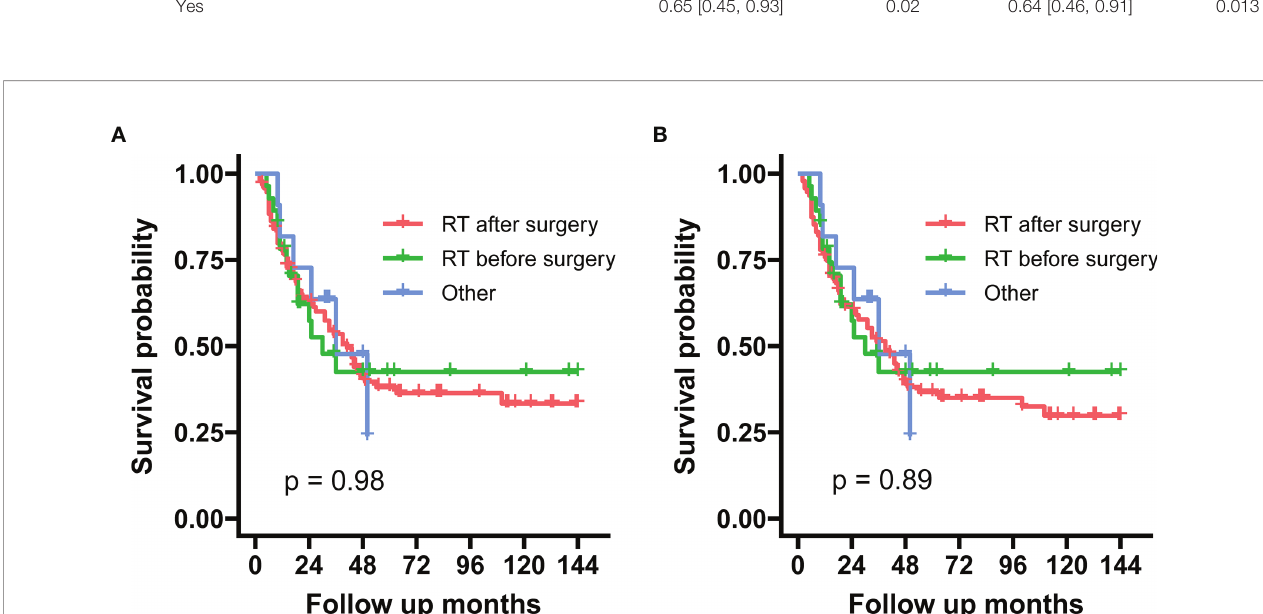
FIGURE 6 | These graphs show Kaplan – Meier survival curves of sarcoma-speci fi c survival (A) and overall survival (B) in the unadjusted cohort between preoperative and postoperative